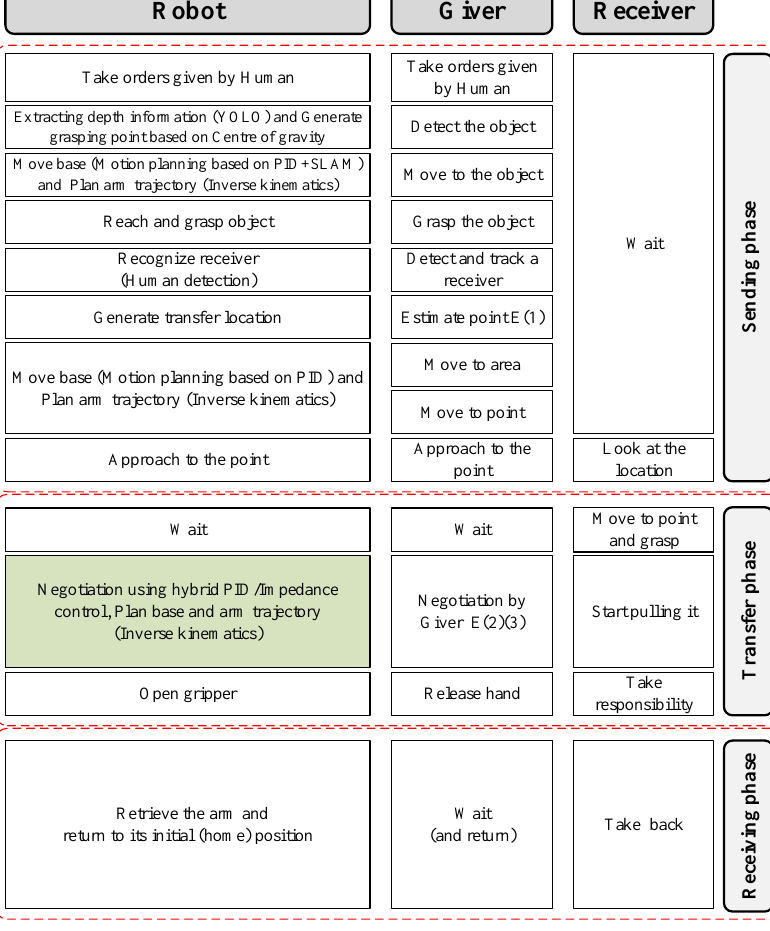
Figure 2. Robot handover framework based on the human–human